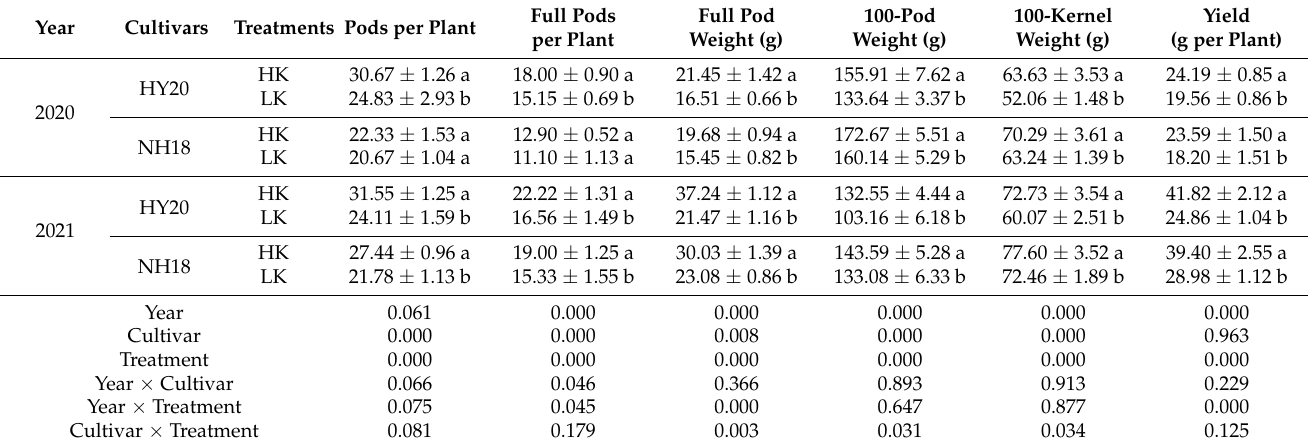
Table 4. Effects of low K stress on yield and yield-related